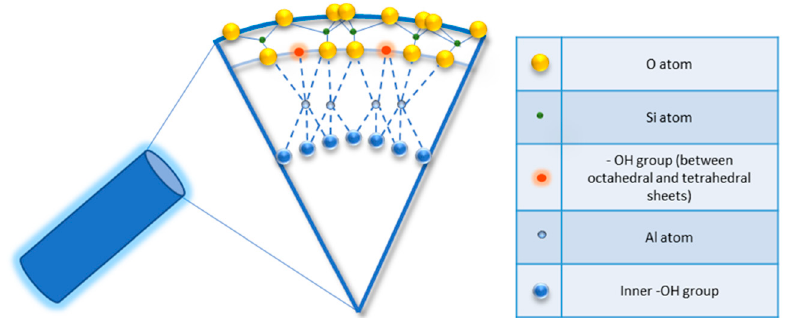
Figure 1. Detail of schematic illustration of the crystalline structure of halloysite nanotubes.